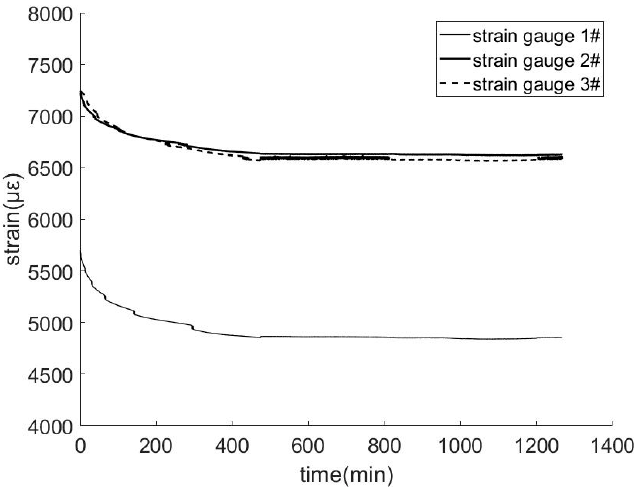
Figure 9. Long-term experiment for composite smart cable No. 2.